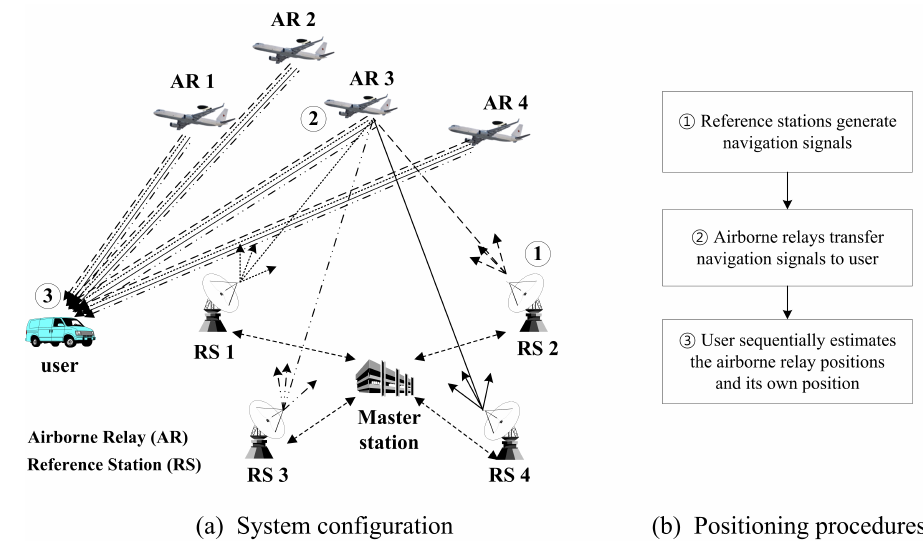
Figure 2. Configuration of the proposed positioning system.